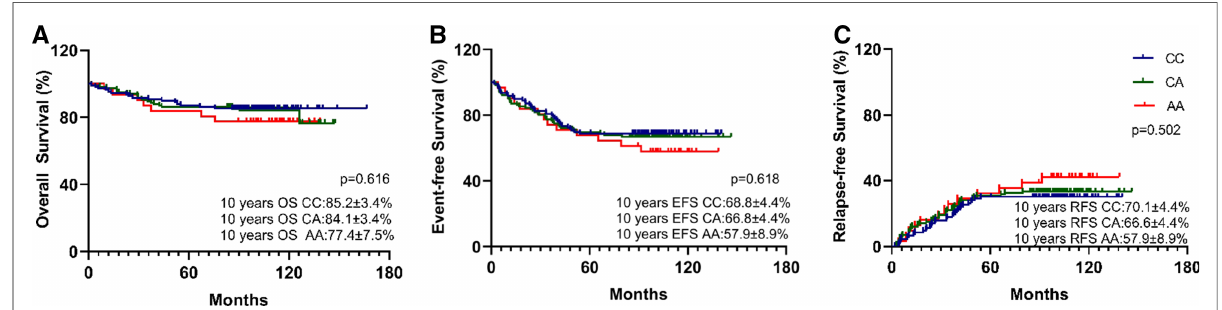
FIGURE 2 Kaplan-Meier curves for 10-year OS ( A ), 10-year EFS ( B ), and 10-year RFS ( C ) by GATA3 SNP rs3824662 genotype (AA, AC, or CC). Differences were assessed using a log-rank test. P -value was 0.616, 0.618, and 0.502 respectively. The A allele has no impact on long-term survival in